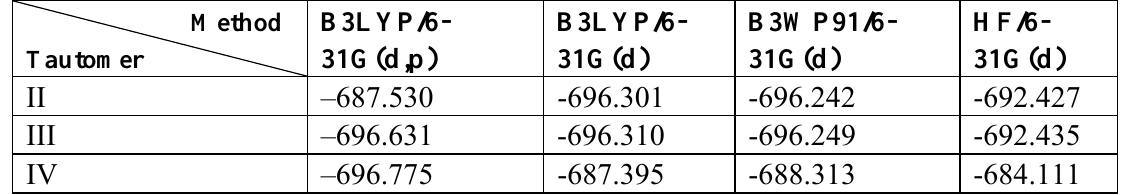
Table 1. Calculated total electronic energies (a.u.) of the three